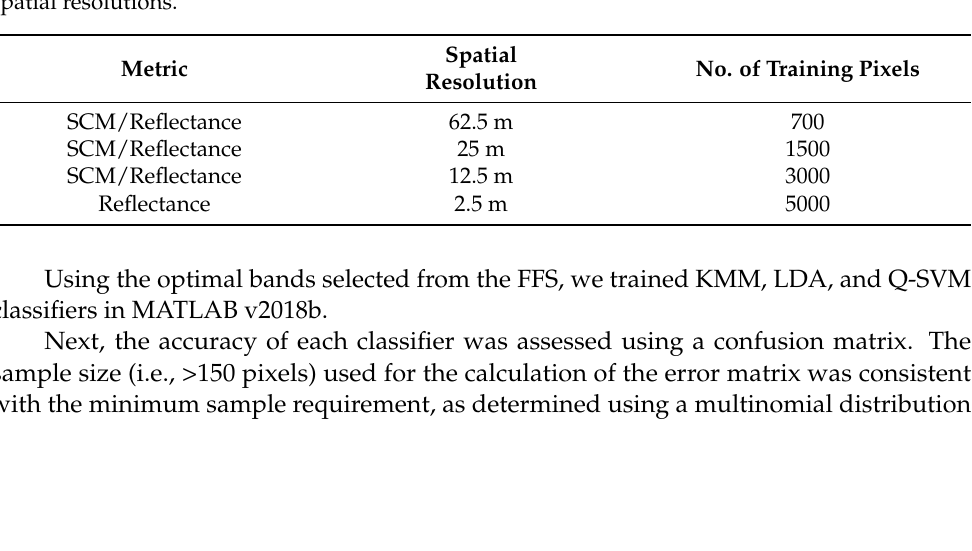
Table 3. Total number of training pixels used for FFS and classification for each metric at different spatial